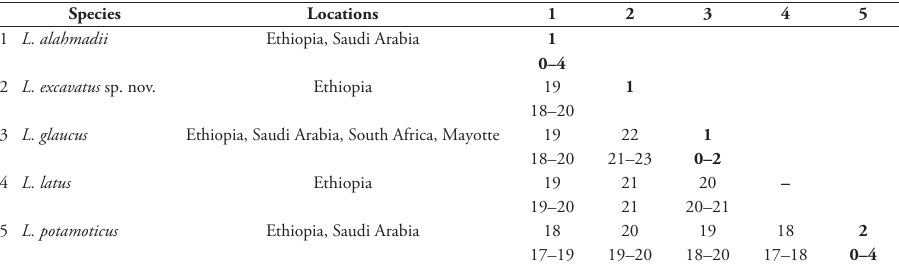
Table 3. Intraspecific (bold) and interspecific genetic distances of the sequenced specimens (COI; Kimu- ra 2-parameter; %, mean,